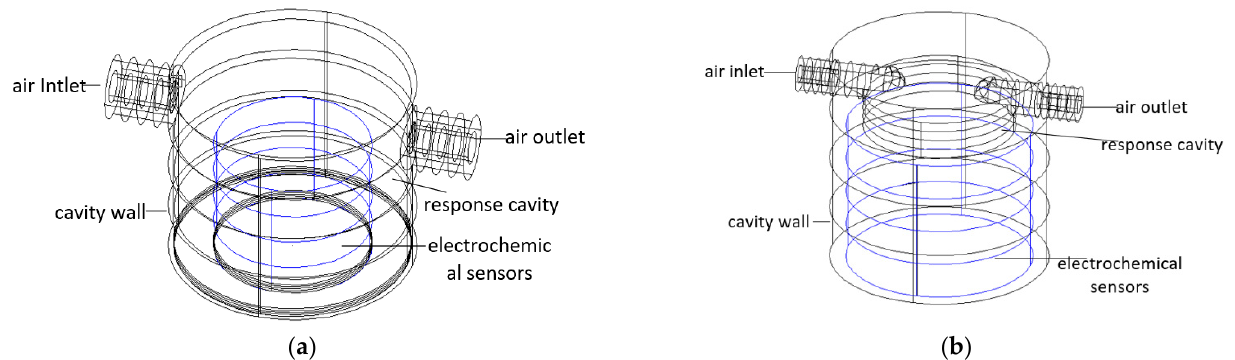
Figure 10. ( a ) Cover cavity structure; ( b ) Cap cavity structure.